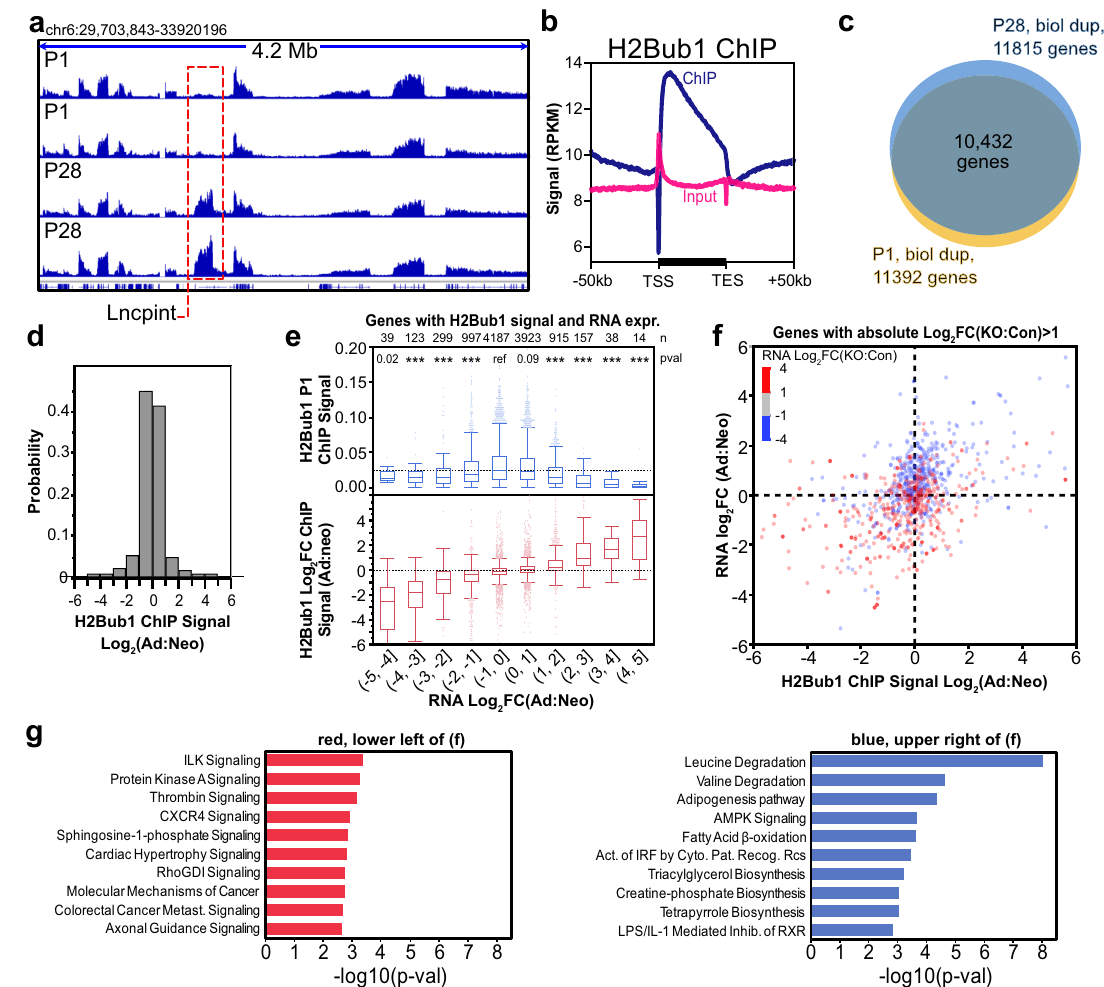
Fig. 5 H2Bub1 regulation of maturational gene expression. a Representative genome browser view of neonatal and adult H2Bub1 ChIP-seq replicates. Dashed red box highlights a gene with dynamic H2Bub1 occupancy. b Pro fi le plot showing average H2Bub1 signal at gene bodies. Plot shows gene bodies and 50 kb upstream of the TSS or downstream of the TSE. c Genes with detectable H2Bub1 ChIP-seq signal at P1, P28, or both timepoints. d Distribution of changes in H2Bub1 signal intensity during maturation, for all genes marked by H2Bub1 in at least one timepoint. e H2Bub1 P1 ChIP signal (top) or the change of H2Bub1 ChIP signal during maturation (bottom) as a function of the gene ’ s maturational change in RNA expression. The change in RNA was binned to contain the indicated range of log2 fold-change values. The change in gene expression correlated with the change in H2Bub1 occupancy, but not with the absolute H2Bub1 occupancy. Numbers at the top of plot (n) indicate genes per bin. Center lines in box plots indicate the median, while boxes show 25th and 75th percentiles. Whiskers denote the maximum observation within the 75th percentile + 1.5 times the interquartile range, or the minimum observation within the 25th percentile − 1.5 times the interquartile range. P -value: Steel – Dwass vs. H2Bub1 P1 ChIP signal in the ( − 1,0] bin; *** P < 0.001. f Maturational change in expression versus maturational change in H2Bub1 signal plotted for genes differentially expressed in RNF20/40-depleted CMs. Color indicates the direction of differential expression in RNF20/40-depleted CMs. Genes with maturational gain in H2Bub1 and RNA expression were predominantly downregulated in RNF20/40 depletion (blue, upper-right quadrant), whereas genes with maturational loss in H2Bub1 and RNA expression were mostly upregulated in RNF20/40 depeletion (red, lower-left quadrant). g Ingenuity pathway analysis of functional terms enriched amongst the indicated genes. Left: Red-colored genes in the lower-left quadrant of panel f (i.e., genes that decrease H2Bub1 and gene expression during maturation and are upregulated in RNF20/40 depletion). Right: Blue-colored genes in the upper-right quadrant of panel f (i.e., genes that increase H2Bub1 and gene expression during maturation and are downregulated in RNF20/40 depletion). P -values were calculated by IPA Core Analysis. Source data are provided as a Source Data fi